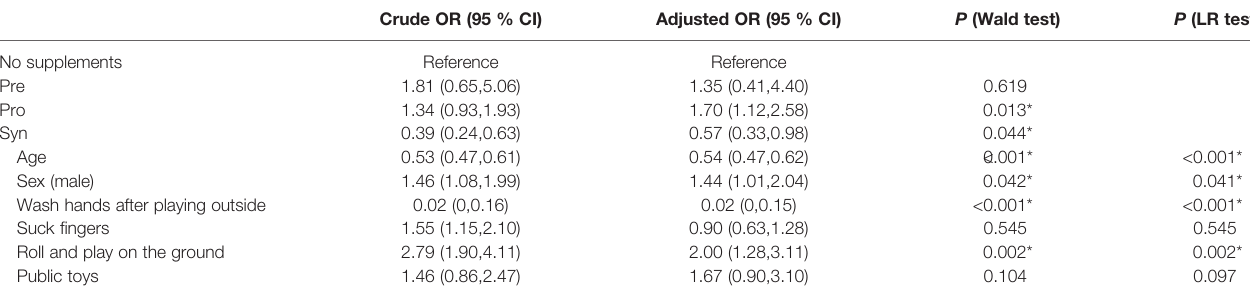
Pro, probiotics supplements. Pre, prebiotics supplements. Syn, synbiotics supplements. 95% CI, 95% con fi dence